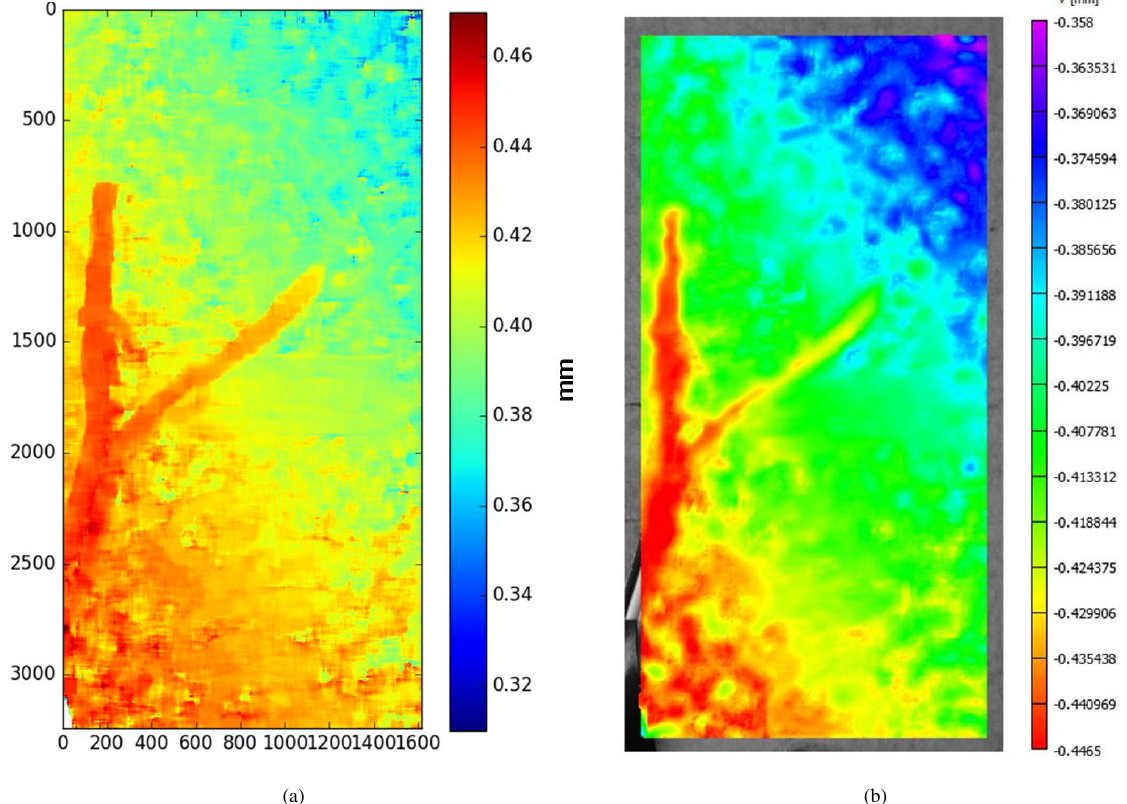
Figure 3: v displacement for the tensile test of GFRP sample obtained from DIC technique. (a) From py2DIC (b) From